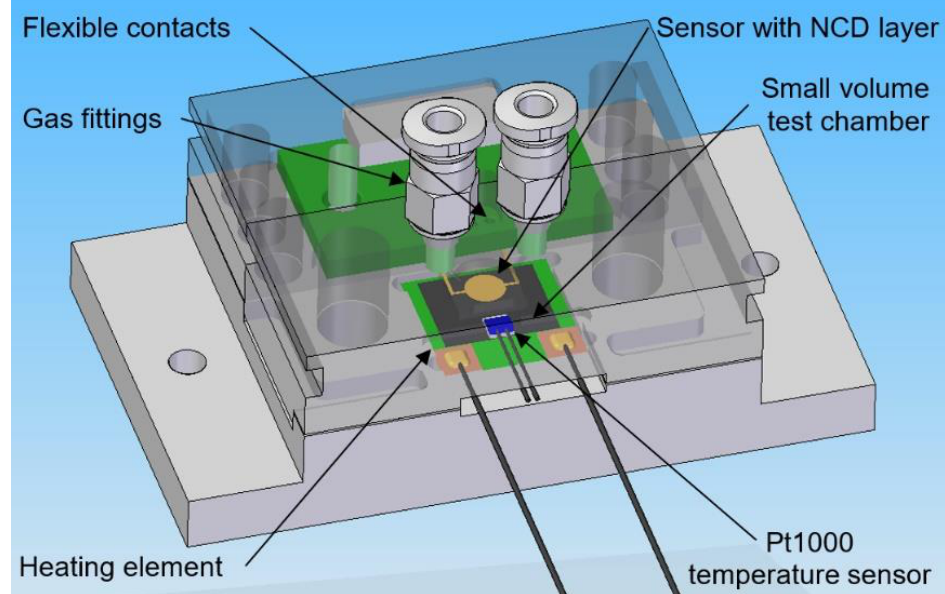
Figure 3. 3D design of testing chamber for NCD sensors with H-termination.